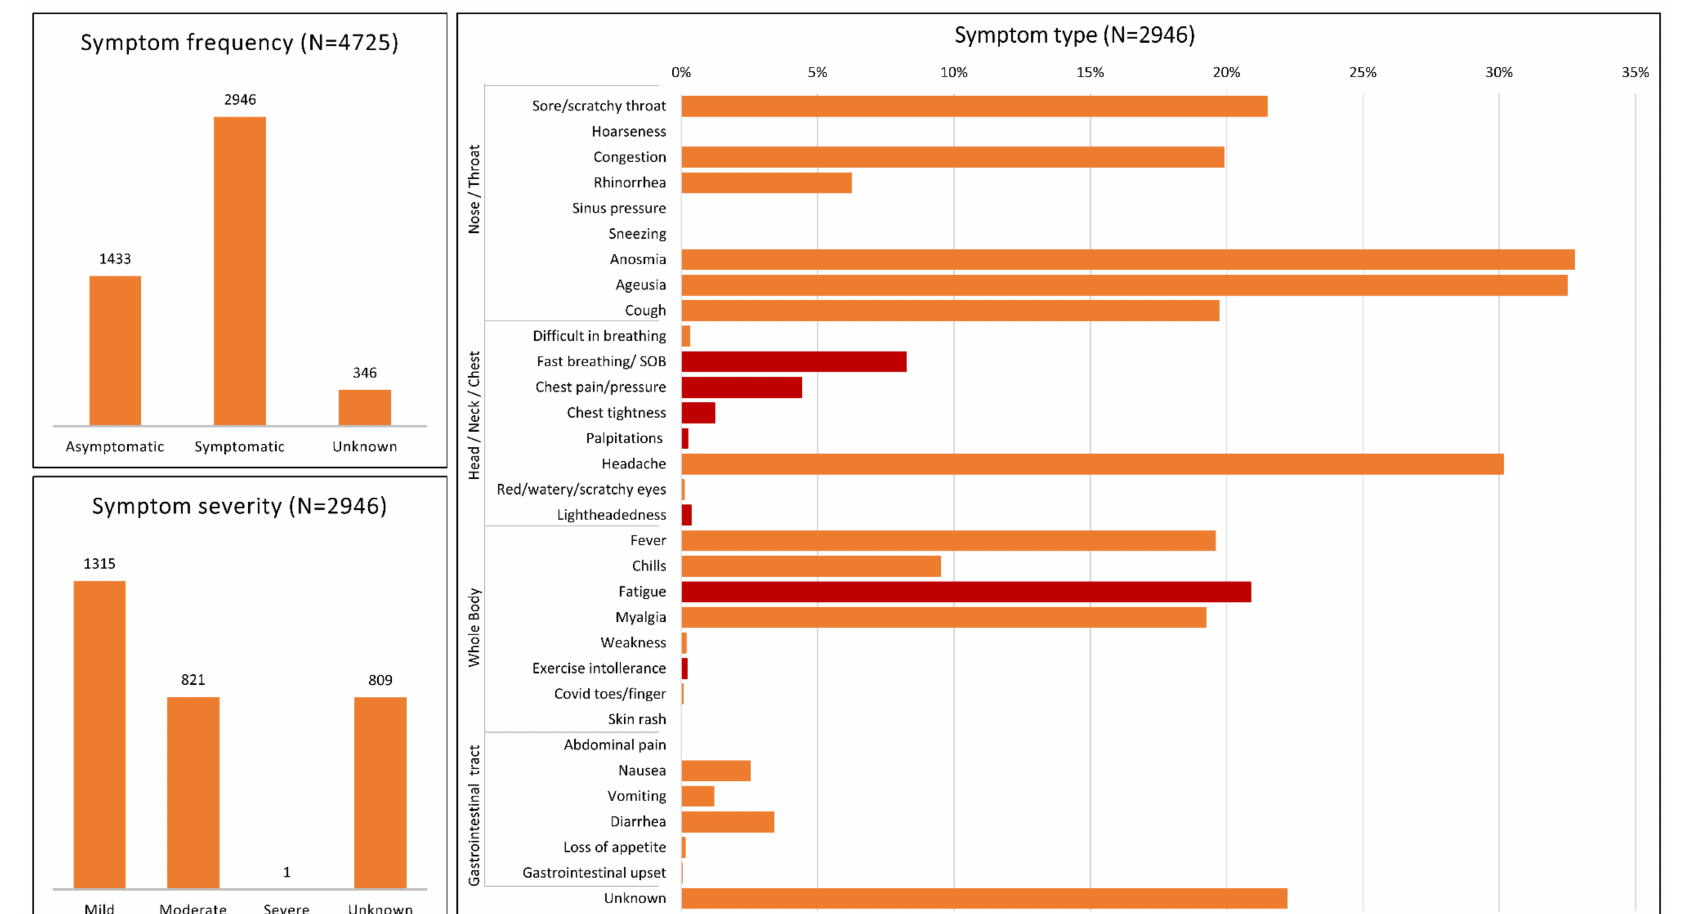
Figure 3. Report of symptoms. Up-left panel shows the distribution of asymptomatic and symptomatic athletes for the cumulative population of athletes (“unknown” indicates subjects who did not report the occurrence of symptoms). Bottom-left panel shows the distribution of symptom severity for the symptomatic athletes. Right panel shows the percentage of symptomatic athletes who reported a specific body-related symptom. Please note that an athlete could indicate the occurrence of one or more symptoms or could indicate or not the body region related to the symptom (“unknown” refers to symptoms for which information related to the body region was not provided). Orange and red bars refer to non-cardiopulmonary and cardiopulmonary symptoms,